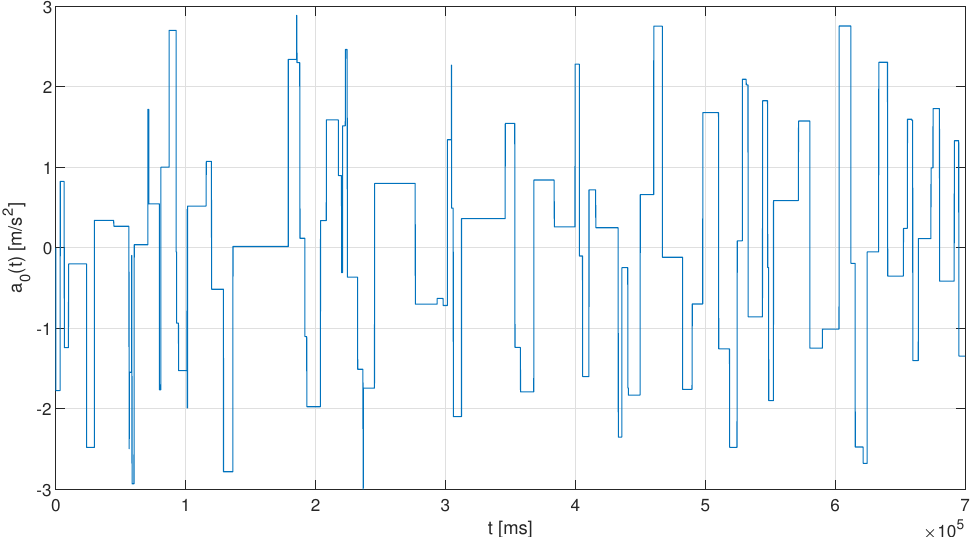
Figure 5. Example of leader acceleration changes (based on z 3 random variable) in a simulation